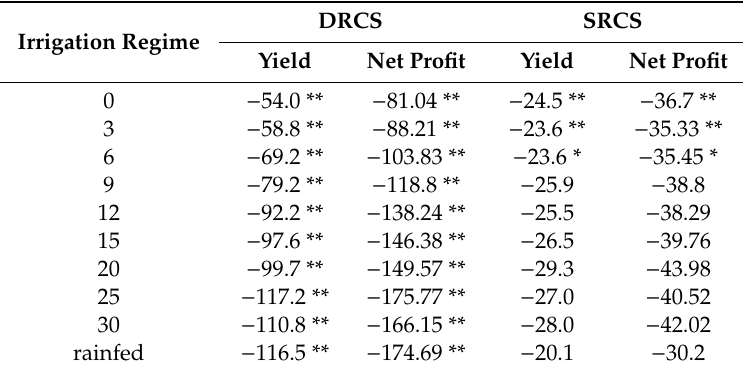
Table 5. The temporal tendency in rice grain yield (kg ha − 1 y − 1 ) and net profit ($ ha − 1 y − 1 ) for DRCS and SRCS at di ff erent irrigation regimes (days after water layer disappeared), including rainfed condition (values are set in italics), during the rice-growing season from 1981 to 2015. DRCS SRCS Irrigation Regime Yield Net Profit Yield Net Profit 0 − 54.0 ** − 81.04 ** − 24.5 ** − 36.7 ** 3 − 58.8 ** − 88.21 ** − 23.6 ** − 35.33 ** 6 − 69.2 ** − 103.83 ** − 23.6 * − 35.45 * 9 − 79.2 ** − 118.8 ** − 25.9 − 38.8 12 − 92.2 ** − 138.24 ** − 25.5 − 38.29 15 − 97.6 ** − 146.38 ** − 26.5 − 39.76 20 − 99.7 ** − 149.57 ** − 29.3 − 43.98 25 − 117.2 ** − 175.77 ** − 27.0 − 40.52 30 − 110.8 ** − 166.15 ** − 28.0 − 42.02 rainfed − 116.5 ** − 174.69 ** − 20.1 −